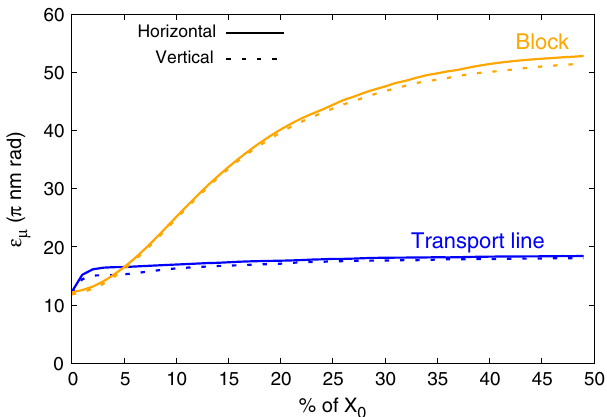
FIG. 5. Muon beam emittance when the target is sliced in units of 1% of a radiation length ( X 0 ) of Beryllium, i.e., 3.5 mm per target. The yellow line shows the effect of the beam divergence inside the material when the targets are one after other, while the blue line shows the effect when the targets are connected by a transfer